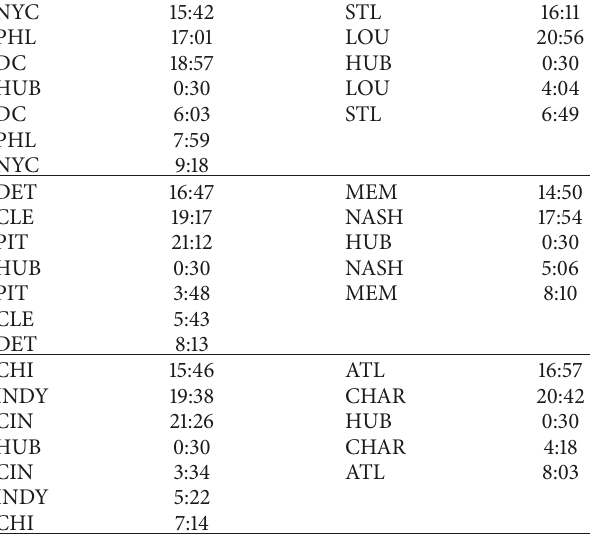
Table 4: Local departure and arrival times of each city in the mass transit system.